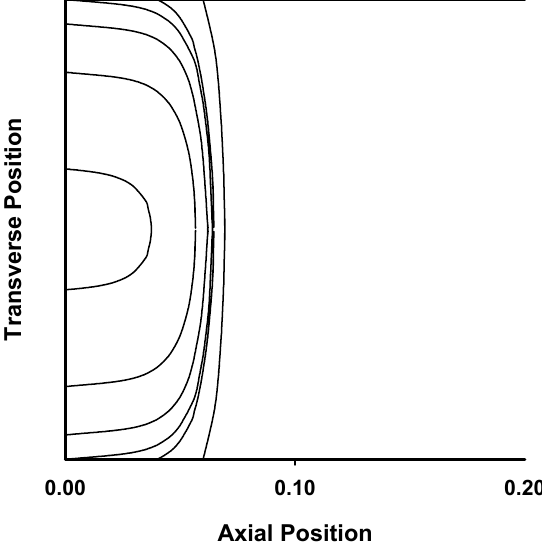
Fig. 4 Schematic illustration of particle trajectories in the surface layers adjacent to the end-walls of a rotating